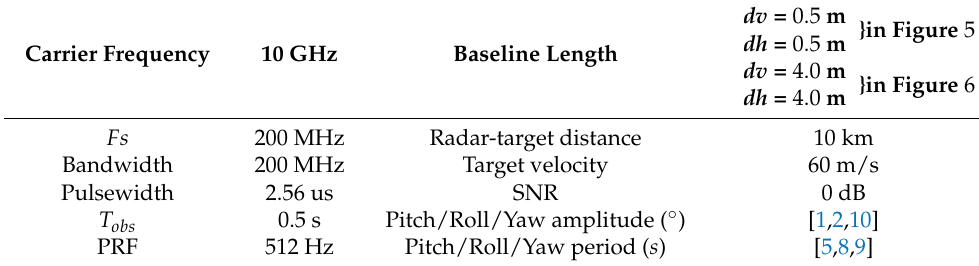
Figure 4. 3D airplane model and ISAR image. ( a ) 3D airplane model. ( b ) Traditional 2D ISAR imaging result. Table 1. Simulation Parameters—Airplane.